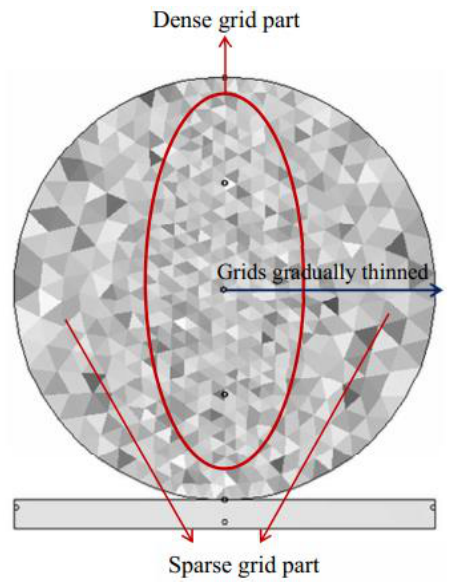
Figure 2. Heterogeneous grid model generated in the optimized DDARF. The technical flowchart of the heterogeneous grid generation in DDARF is shown in Figure